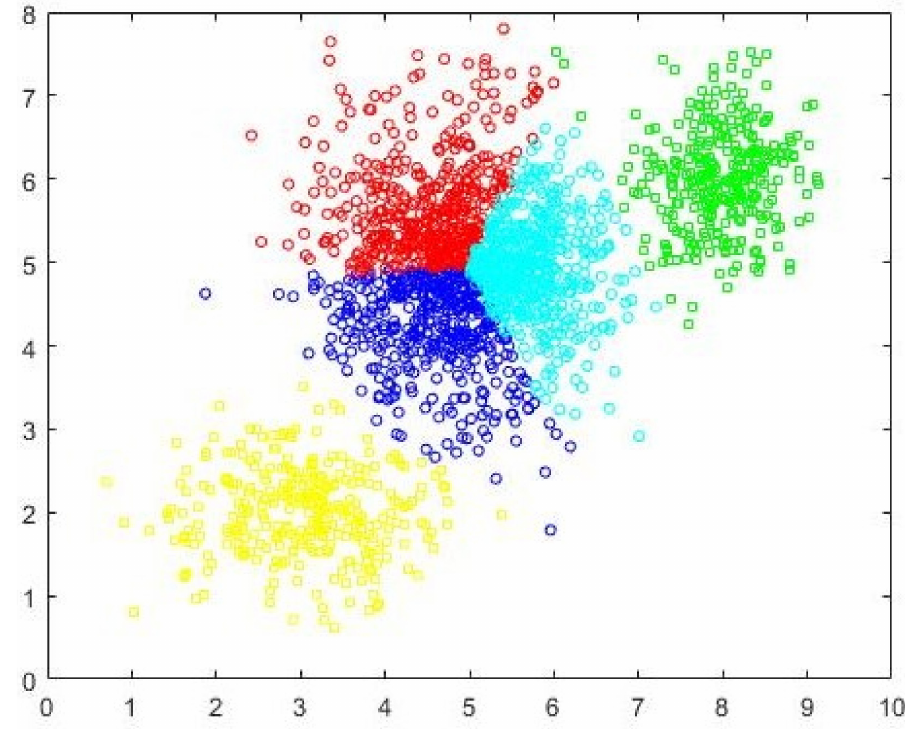
Figure 8. Best partition by FCM-AO, c = 5 with randomly initialized cluster prototypes.